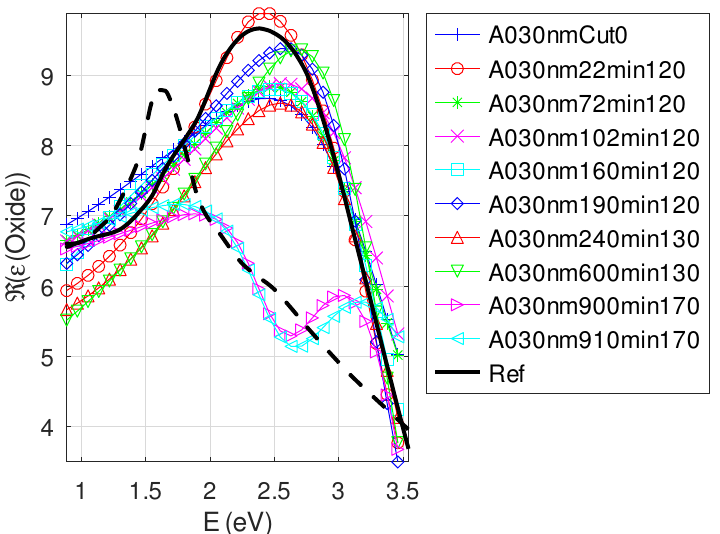
Figure A9. Real part of the relative permittivity of oxide as a function of the photon energy: bulk Cu 2 O (black solid line), bulk CuO (black dashed line) and best calculated (color) for each oxidized = 30 nm). sample (initial thickness h 0 Cu